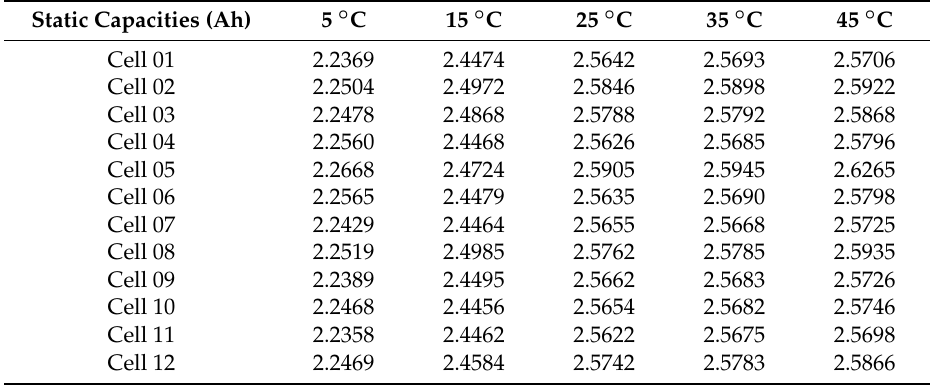
Table 2. Experimental results of static capacities (Ah) under different ambient temperatures for 12-cell. Static Capacities (Ah)